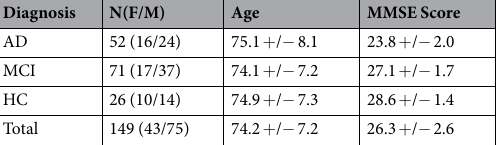
Table 3. Clinical and demographic information of the 149 ADNI subjects considered in this study, selected based on the availability of imaging, non-imaging and clinical metrics at baseline. The dataset was split into independent training set with 60 cases (40%) and a holdout validation set with 89 cases (60%). Note that gender information was unavailable for a subset of the data, as a result of which N does not equal to the sum of females (F) and males (M).